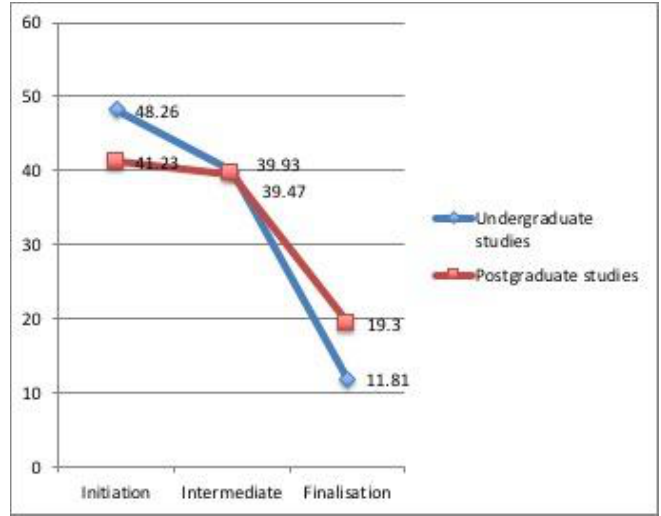
Figure 5 . Stages of tackling the task: comparison of undergraduate and postgraduate students’ discussion board activity